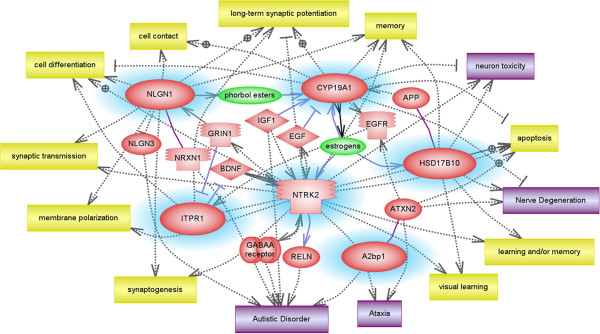
Pathway analysis of selected potential transcriptional targets of RORA. A biological network was created using the Pathway Studio 7.0 program to identify biological functions and disorders associated with potential RORA transcriptional targets selected for confirmation (that is, ITPR1, CYP19A1, A2BP1, HSD17B10, NLGN1, and NTRK2 which are highlighted with a blue halo).